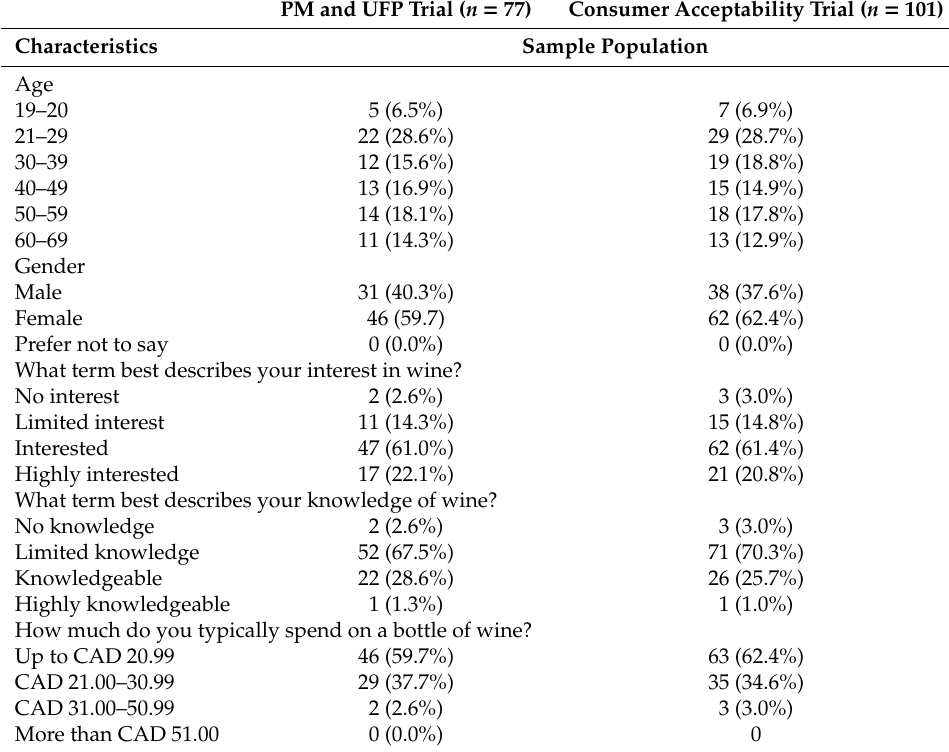
Table 2. Demographic details for each